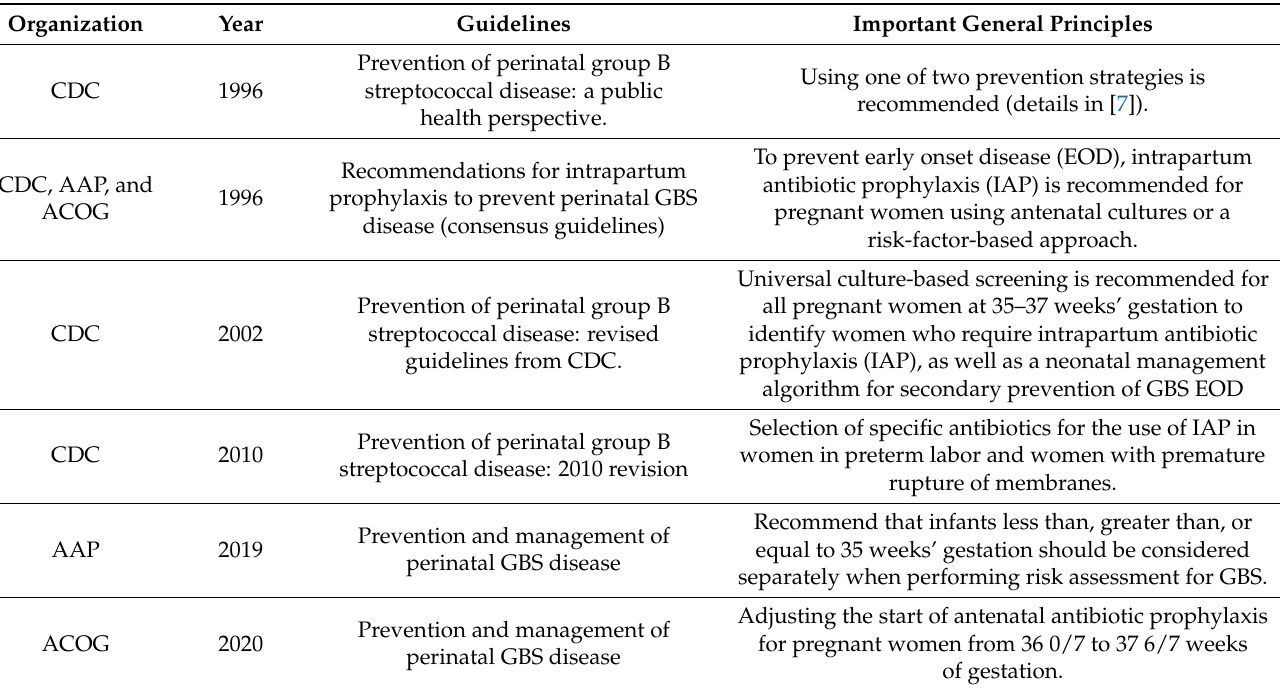
Table 1. Summary of the key guidelines and their general principles for prevention of GBS